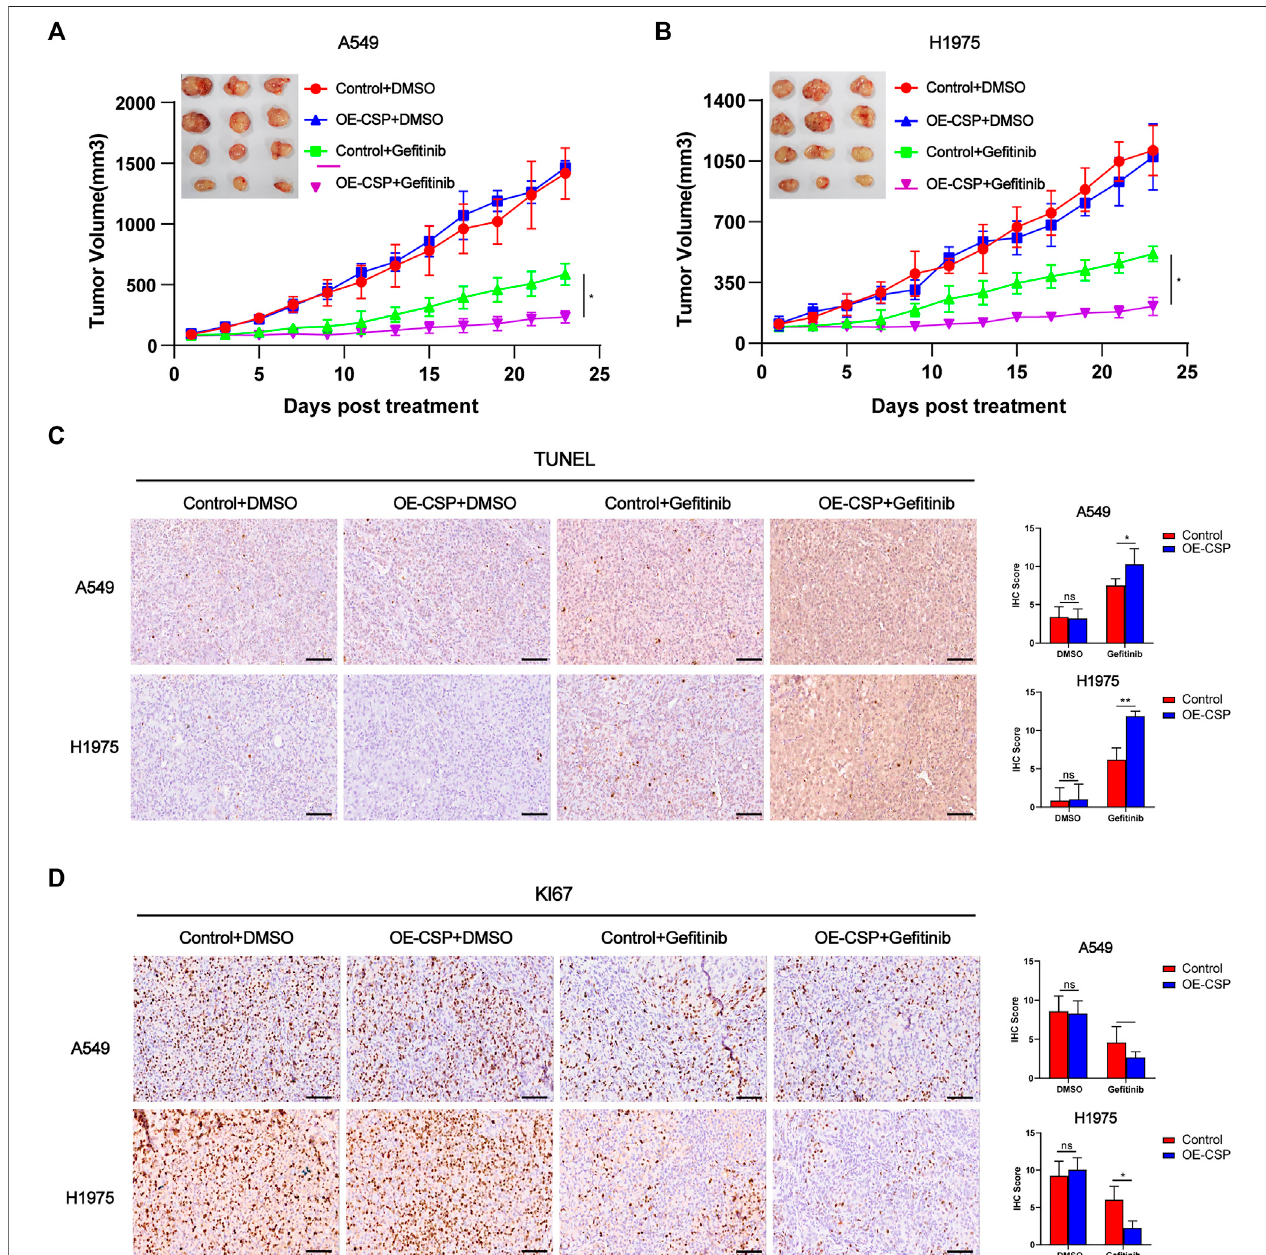
FIGURE 2 | Overexpression of CSP enhances ge fi tinib-mediated inhibition of cell proliferation in vivo. Control and OE-CSP A549 (A) and H1975 (B) cells (5 × 10 6 ) were subcutaneouslyinjectedintonudemiceandge fi tinibwasstartedwhenthetumorvolumeapproached100 mm 3 .Experimentswererepeatedtwotimeswiththreemicepergroup per experiment. The growth curves for the four groups were drawn and the fi nal tumors were photographed. The tumor tissues were subjected to immunohistochemistry (IHC) staining for TUNEL (C) and Ki67 (D) . Representative images for IHC ( left ) and statistical histograms ( right ). Scale bar, 50 μ m, n = 21 (* p < 0.05, ** p < 0.01).